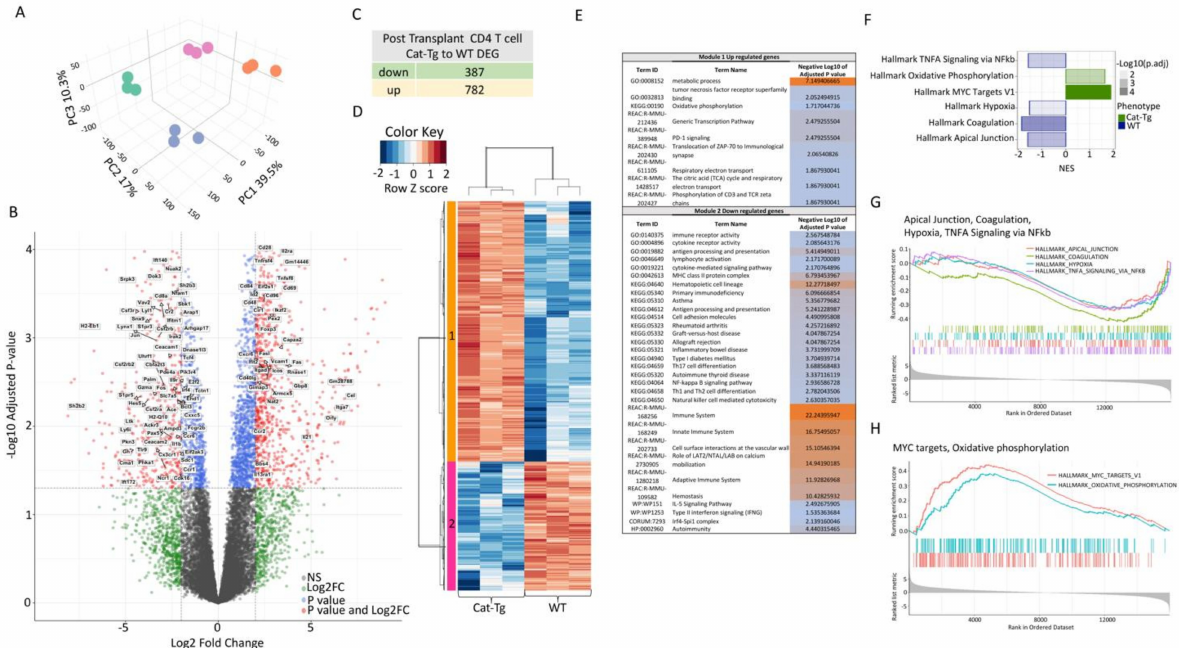
Figure 6. β -catenin overexpression differentially regulates gene expression in CD4 + T cells. ( A ) 3D graph of PCA analysis showing clustering of pre-tx and post-tx day 7 CD4 + T cells for strain and timepoint by color. All replicates are shown ( n = 3). ( B ) Volcano plot displaying 1169 differentially expressed genes (FDR 0.05, logFC 2) between Cat-Tg and WT pre-tx ≤ ≥ CD8 + T cell samples. Positive log fold change corresponds to increased expression in Cat-Tg samples. ( C ) Table showing the number of up- or downregulated DEGs between groups. ( D ) Hierarchical clustering and heat map illustrating expression of genes compared between different groups selected by strain and timepoint. All replicates are shown ( n = 3) for each group. ( E ) Table showing GO enrichment analysis of DEG of pre-tx CD4 + T cells. Using the online tool gProfiler and the ordered g:GOSt query, we assessed which biological processes (BP) were linked to the genes in the different modules from pre-tx CD4 + T cells. On the table, adjusted p -values were color-coded as light blue for insignificant findings to orange with highest significance. ( n = 3 mice per group). ( F ) A bar plot showing up- or downregulated pathways based on enrichment scores in GSEA in pre-tx WT or Cat-Tg CD4 + T cell samples. Negative Normalized Enrichment Score (NES) is indicator of downregulation and positive NES is indicator of upregulation of the genes in the corresponding pathway. Color specifies the group ( WT or Cat-Tg) in which expression is altered (phenotype), color transparency indicates the negative Log10 of adjusted p value. ( G ) GSEA enrichment plots of gene clusters that are enriched in WT, including Hallmark of Apical Junction, Hallmark of Coagulation, Hallmark of Hypoxia, and Hallmark of TNF-a Signaling via NF-kb. ( H ) GSEA enrichment plots of gene clusters that are enriched in Cat-Tg , including Hallmark of MYC targets and Hallmark of Oxidative